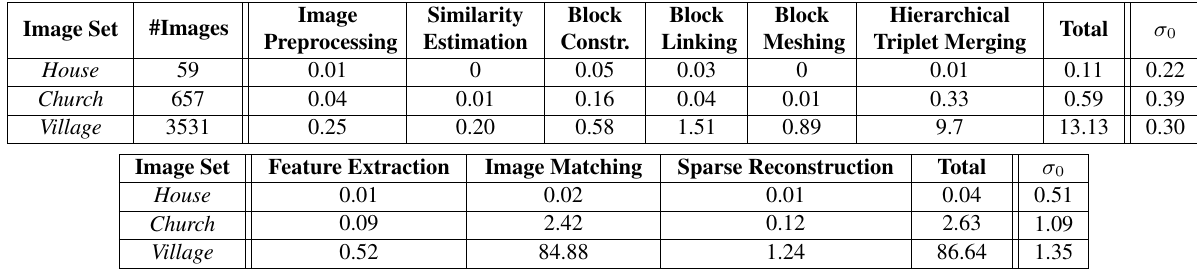
Figure 6. Runtimes in hours for each stage of the proposed SfM approach (top) and VisualSFM (bottom) as well as the achieved accuracy ( σ 0 ) in pixels for the presented image